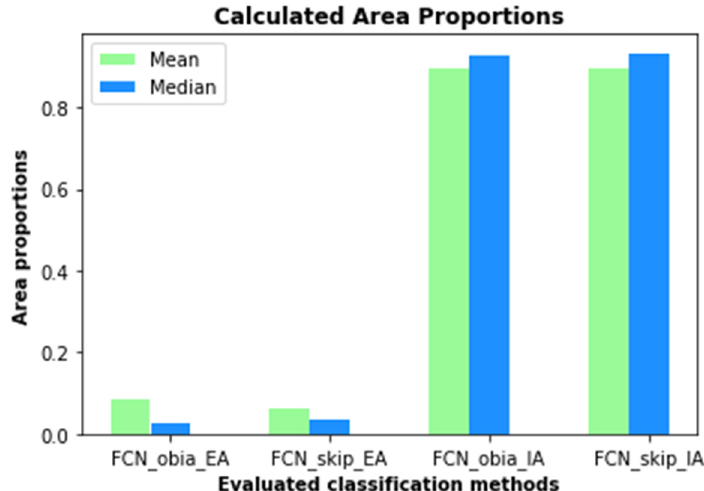
Figure 6. A chart that illustrates the calculated area proportions for the area of classified pixels outside the reference polygon (EA) and the area of classified pixels within the reference polygon (IA). Both mean and median values are presented to consider any outliers that might be present in the data. The areas have been computed for FCN_ skip and FCN_ obia0550 experiments.